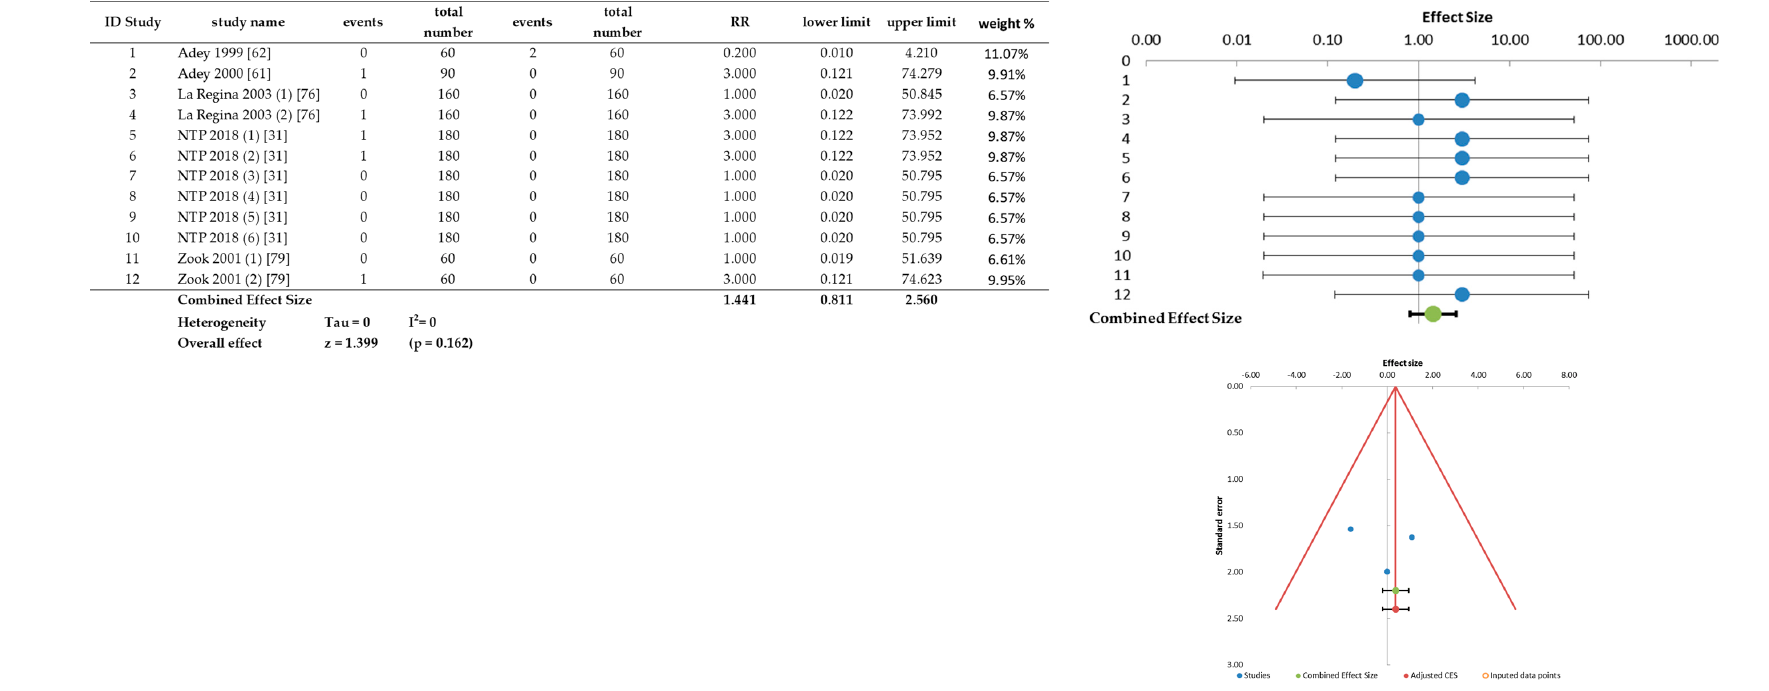
Figure 6. Forest plot and raw data of the spinal cord malignant tumors.